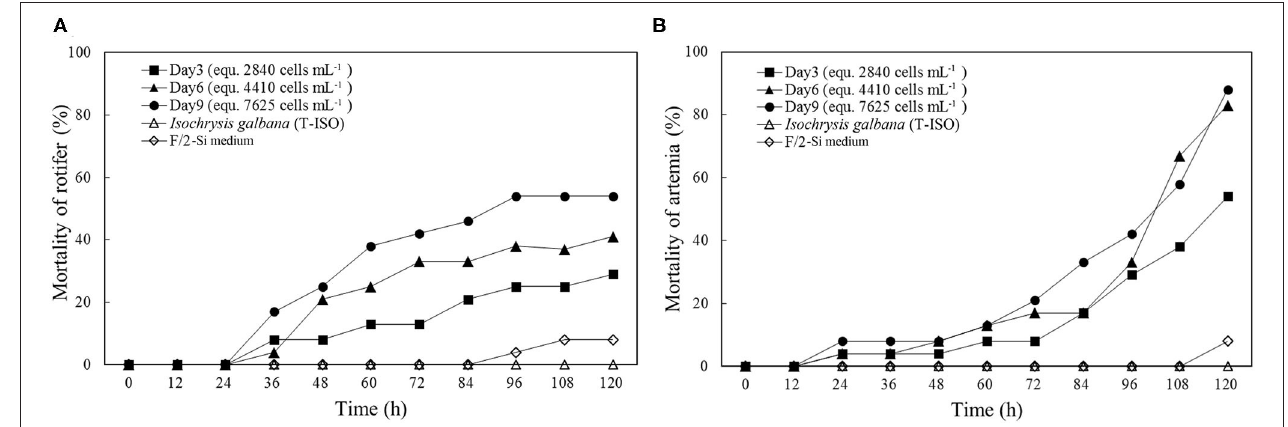
FIGURE 7 | Mortality of rotifer (A) and brine shrimp (B) in the bioassays using cell-free culture mediums at the initial, exponential, and stationary growth phases (Day 3, 6, and 9, respectively). F/2-Si medium and Isochrysis galbana (strain T-ISO) were used as negative